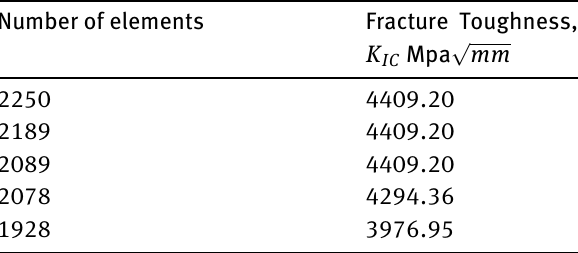
Table 3: Convergence of numbers of elements used in the finite element